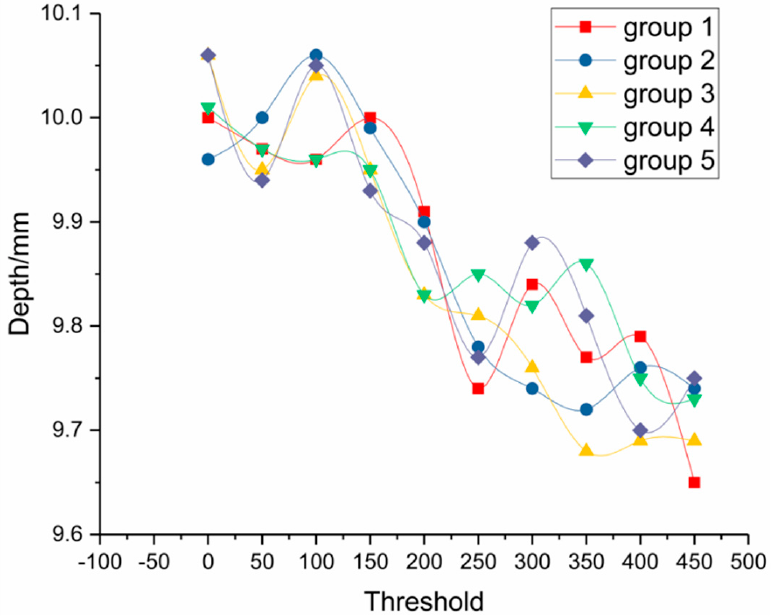
Figure 13. The measurement data under different pixel thresholds.